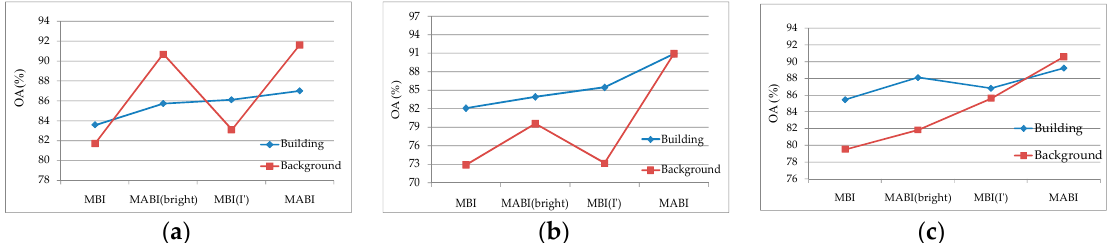
Figure 12. The OA of the building feature detection results of the MBI and MABI based on different input images: the bright image and I ʹ . ( a – c ) are the statistical results of Dataset 1, Dataset 2, and Dataset 3, respectively.